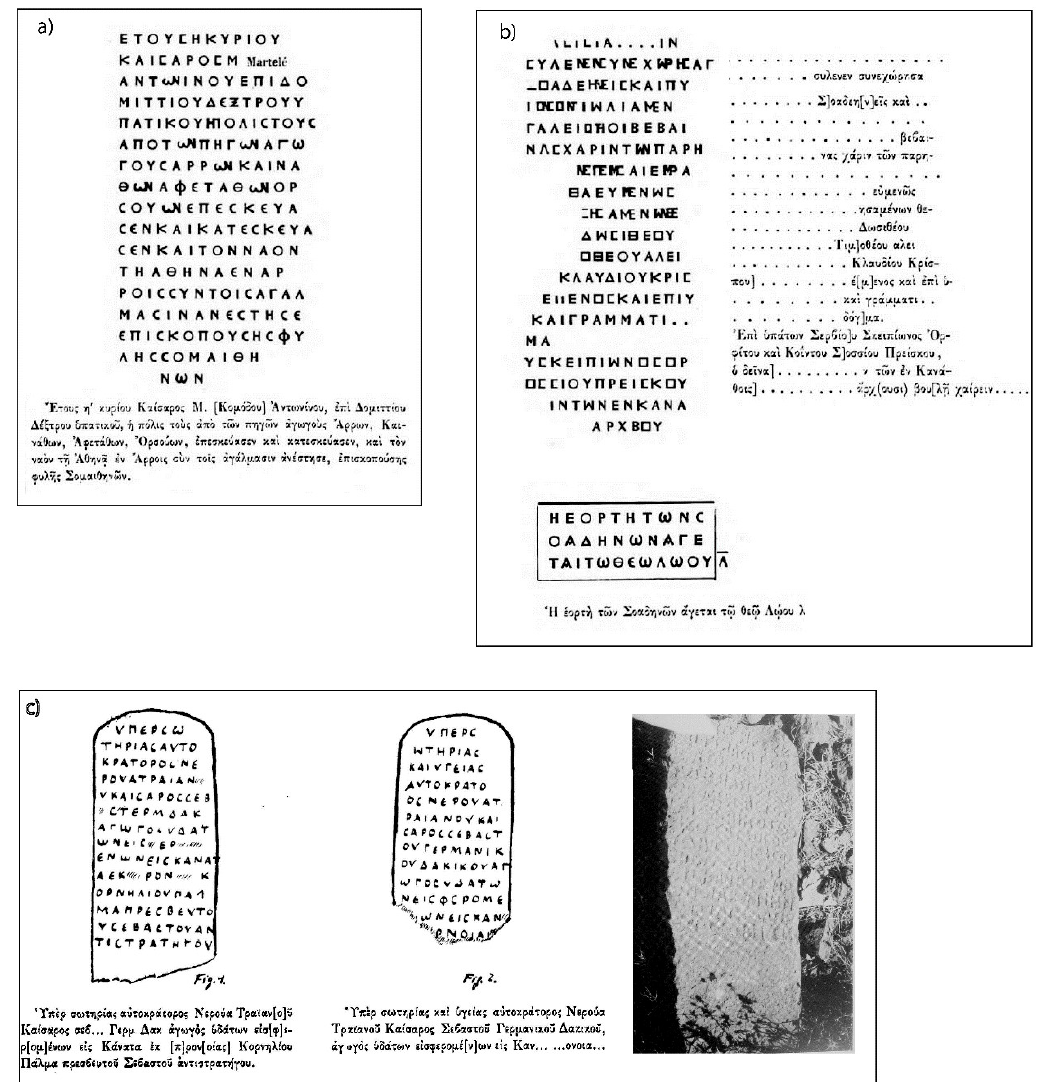
Figure 9. Inscriptions pointing to bi-directional relationships between the settlements. ( a ) Inscription from Soada about the renovation of water channels ( agogoi ) from Arra, Aphetata, and Orsua, and the construction of a temple and a statue of Athena by the demos of Soada at Arra. [86] (no. 2308). ( b ) Inscriptions on stelai from Soada (left) and el-Arra (center) and the stela from Zawiyet Balahat, speaking about the water that was directed from Kanatha to Soada. [89] (Figure 1. 2). ( c ) Inscriptions from Soada (left) and Dmeir el-Smedj (right) about a feast at Dmeir el-Smedj involving both communities. [86] (no. 2307. 2370).